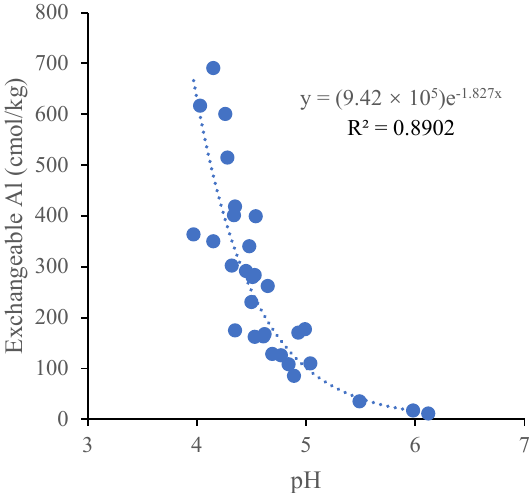
Figure 3. Relationship between pH and exchangeable aluminum in soils around disease bayberry roots. Each dot represents a soil sample in the figure.